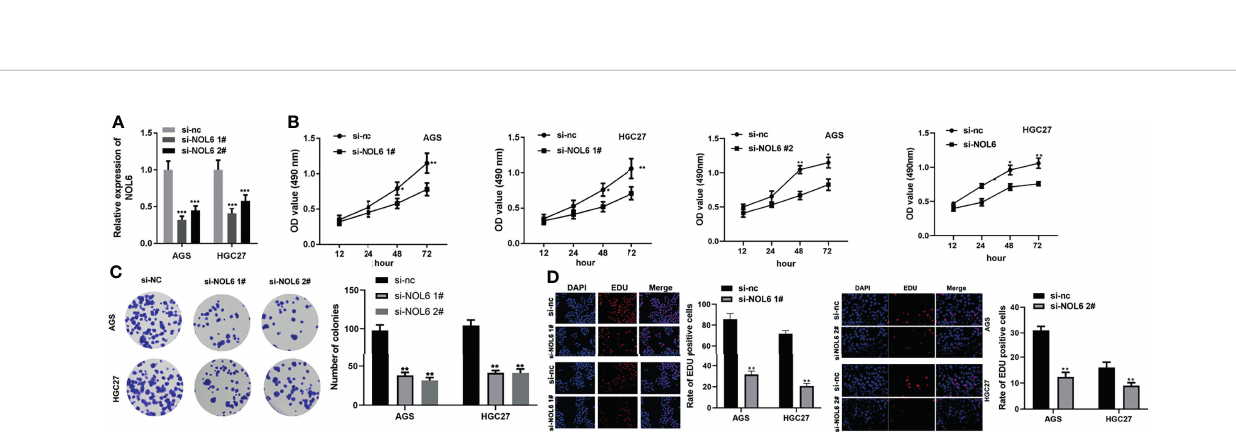
FIGURE 4 | NOL6 knockdown suppressed proliferation and colony formation of AGS and HGC cells. (A) Effect of si-NOL6 1# and si-NOL6 2# on the gene expression of NOL6 in the AGS and HGC cells. (B) Effect of si-NOL6 on the viability of the AGS and HGC cells was evaluated by MTT assay. (C) Effect of si-NOL6 on the number of colonies in the AGS and HGC cells was detected by colony formation assay. (D) Effect of si-NOL6 on the proliferation of the AGS and HGC cells was assessed by EDU staining. (*p < 0.05, **p < 0.01, ***p < 0.001 v.s.si-nc).